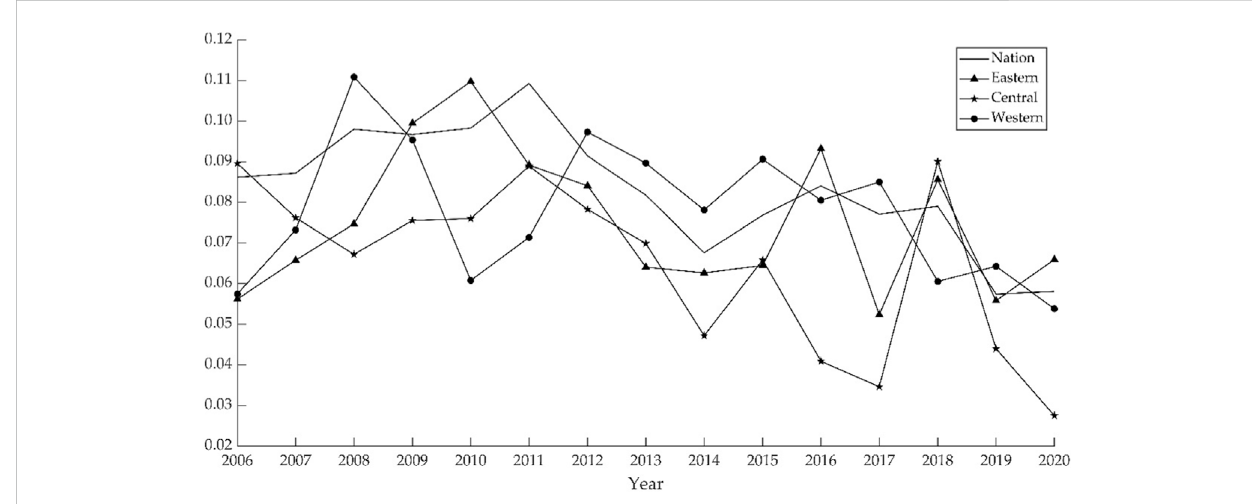
FIGURE 9 Evolution trend of the variation coef fi cient of green development quality in the construction